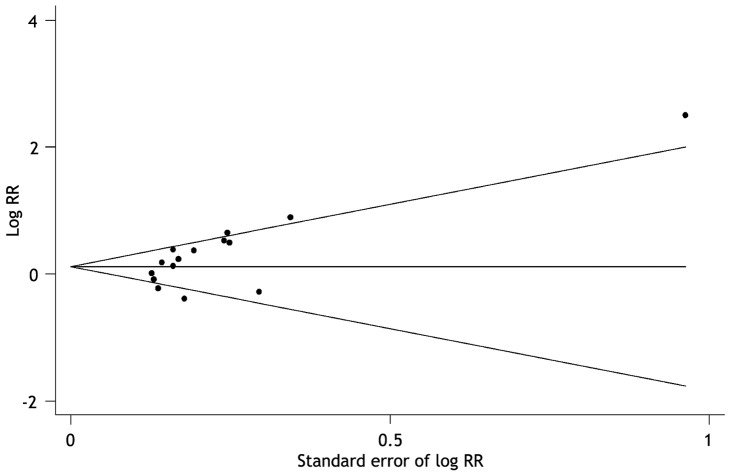
Funnel graph for the assessment of potential publication bias in talc pleurodesis compared with control therapies for malignant pleural effusion.The funnel graph plots log of relative risk (RR) against the standard error of the log of RR. Each solid circle represents each study in the meta-analysis. The line in the center indicates the summary RR.